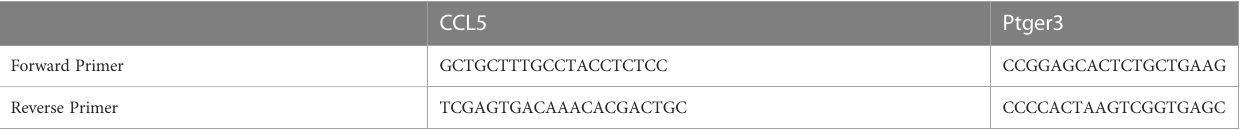
TABLE 1 Primer sequences of mouse Ccl5 and